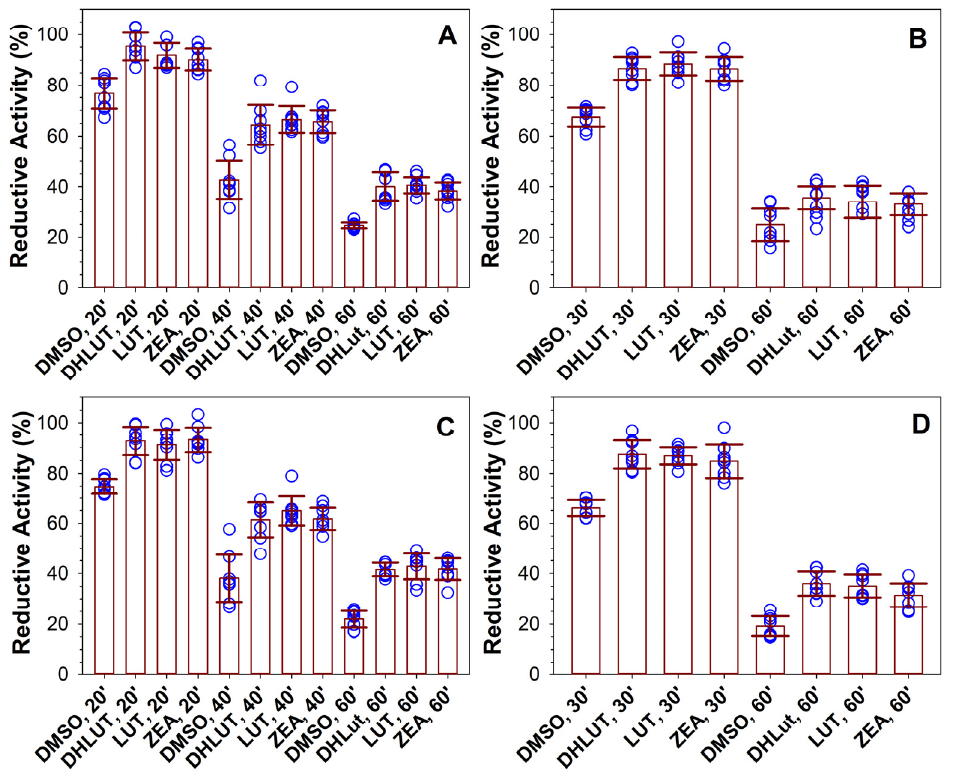
Figure 9. The presence of extracellular carotenoids partly protects cells from damage induced by photosensitizers and light independently of whether the cells underwent prior supplementation with carotenoids. ( A , B ): Reductive activities of ARPE-19 cells after 19 days of supplementation with vehicle (DMSO) or carotenoids: dehydrolutein (DHLut), lutein (LUT), and zeaxanthin (ZEA) measured by MTT assay immediately after 20, 40, or 60 min of exposure to visible light and 0.5 µ M rose bengal ( A ) or 24 h after 30 or 60 min of exposure to visible light and liposomes containing 0.5 mM all- trans -retinal and 2.8 mg/mL EYPC (B). The exposure to photosensitizers and light was in the presence of 0.2% DMSO and 2 µ M carotenoids solubilized in DPBS. ( C , D ): Reductive activities of cells without prior feeding with carotenoids, which were exposed to light, photosensitizers, and carotenoids. The MTT assay was performed immediately after the exposure to light and 0.5 µ M rose bengal ( C ) or 24 h after the exposure to light and all- trans -retinal ( D ). The exposure to photosensitizers and light was in the presence of 0.2% DMSO and 2 µ M carotenoids solubilized in DPBS. The symbols indicate individual measurements, the heights of the bars indicate means, and the error bars indicate SDs. Treatments with carotenoids resulted in a statistically significant increase in the reductive activities in comparison with DMSO-only-treated cells in all types of experiments ( p < 0.001). The differences between the effects of different carotenoids in the same type of exposure were not statistically